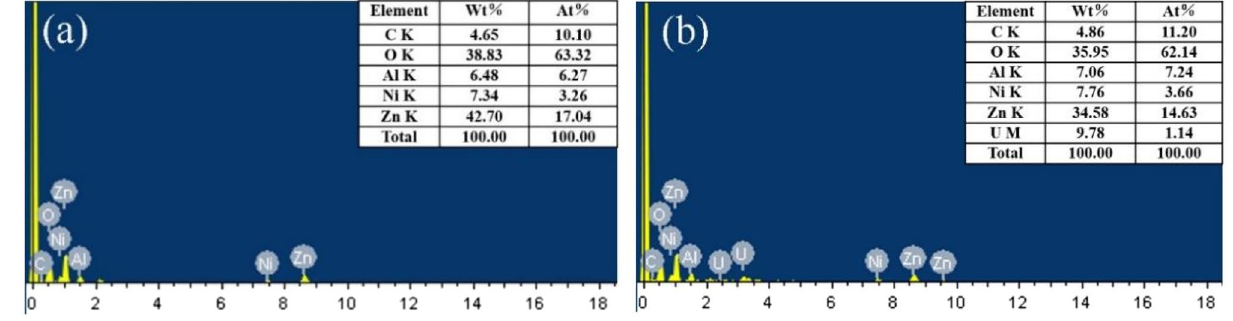
Figure 9. EDS patterns of ZnNiAl-LDHs before ( a ) and after ( b ) U(VI)